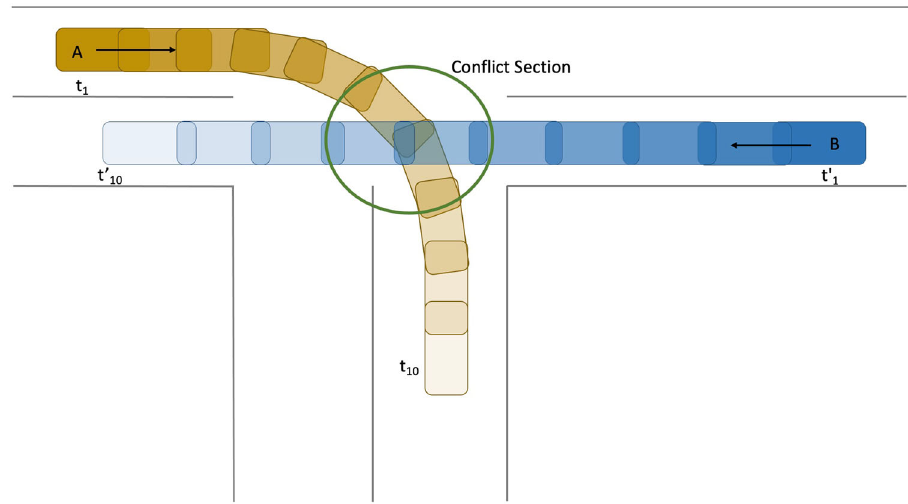
Fig. 2 Illustration of yielding scenario. This fi gure shows the trajectories of two vehicles approaching an intersection where one vehicle is required to yield the right-of-way to